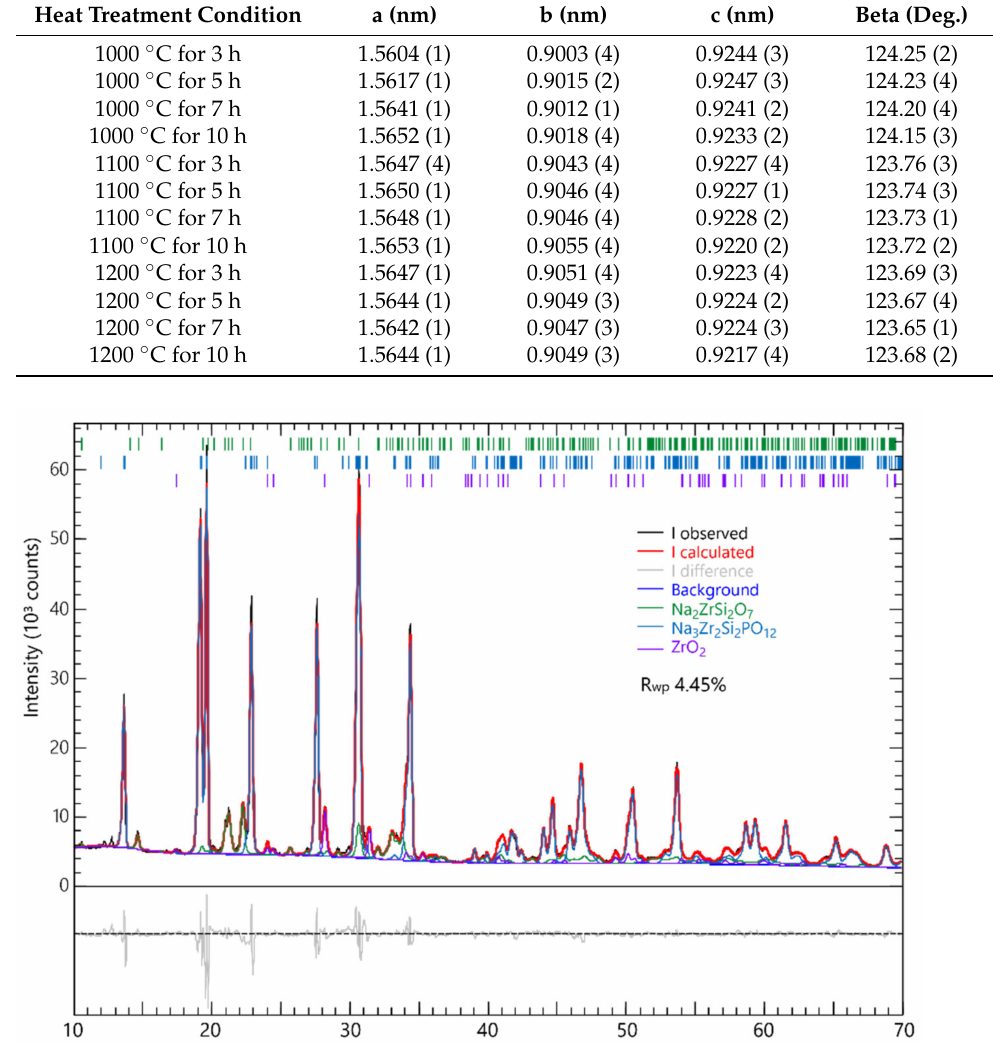
Table 1. Refined lattice parameters of LPS-NZSP.